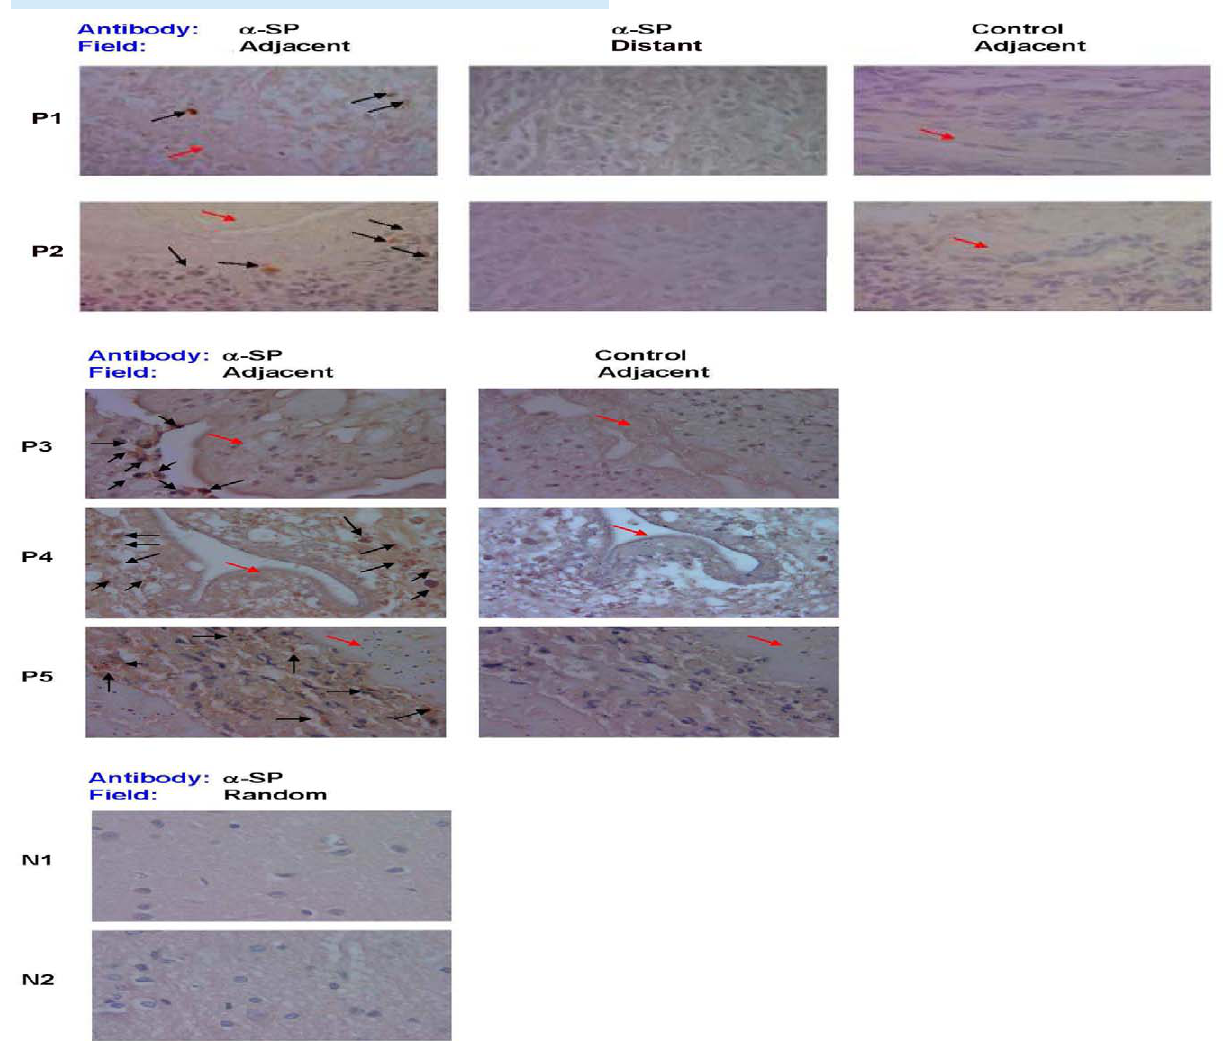
Figure 1. SP immunostaining of brain tissue samples from NCC-infected and uninfected patients. Photomicrographs of brain biopsy specimens of NCC-infected patients (P1 through P5) and brain autopsy specimens of NCC-uninfected patients (N1 and N2) are shown. Specimen slides were stained with specific polyclonal rabbit anti-SP antibody ( a -SP) or control rabbit serum. Fields shown are either adjacent to the parasite (indicated by red arrow) or distant from parasite [when specimen size permitted (P1 and P2)], as indicated. SP + cells are indicated by black arrows, 1000 6 magnification. Data shown is representative of one independent experiment. doi:10.1371/journal.ppat.1002489.g001 PLoS Pathogens |